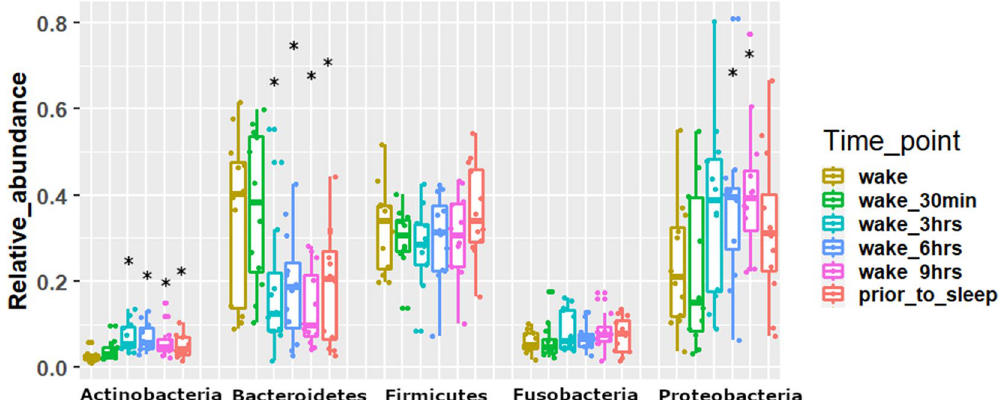
Figure 4. Taxonomic summary of relative abundance based on phyla abundance. X-axis represents the major bacterial phyla observed here while Y-axis represents the corresponding relative abundances. For each phylum, six plots have been made and each box represents a time point. Each boxplot has been made based on the relative abundance of the phylum for the 12 subjects. Mann–Whitney test was used to determine if the relative abundances of any phylum differ across the time-points (represented by color of each boxplot) with reference to the ‘wake’. Asterisks over a boxplot denote significant difference (increase or decrease) in relative phylum abundance in comparison to ‘wake’ time point.